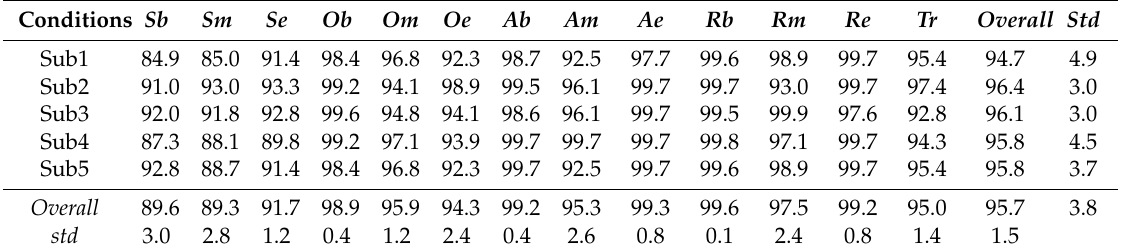
Table 8. The component level recognition result at Θ = 3(%) (Sub5 as reference